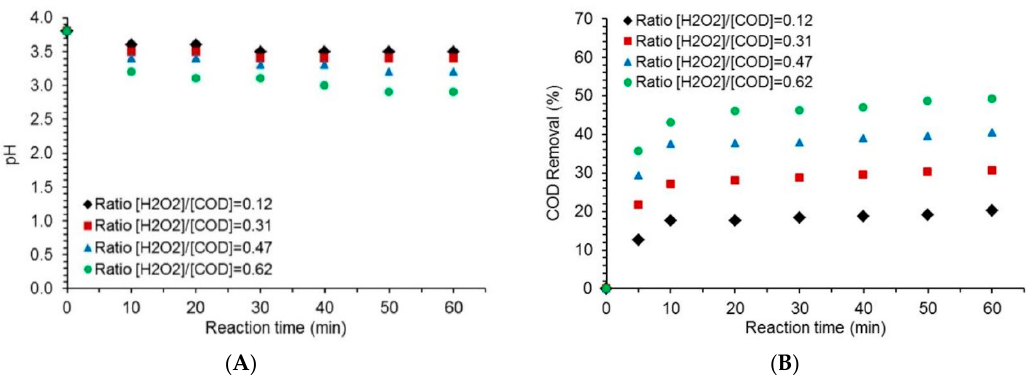
Figure 2. The pH profile ( A ) and removal of COD ( B ) by the Fenton reaction at different [H 2 O 2 ] to [COD] ratios for pH = 3.8 (without adjustment) and the ratio of [H 2 O 2 ] to [Fe 3+ ] = 50